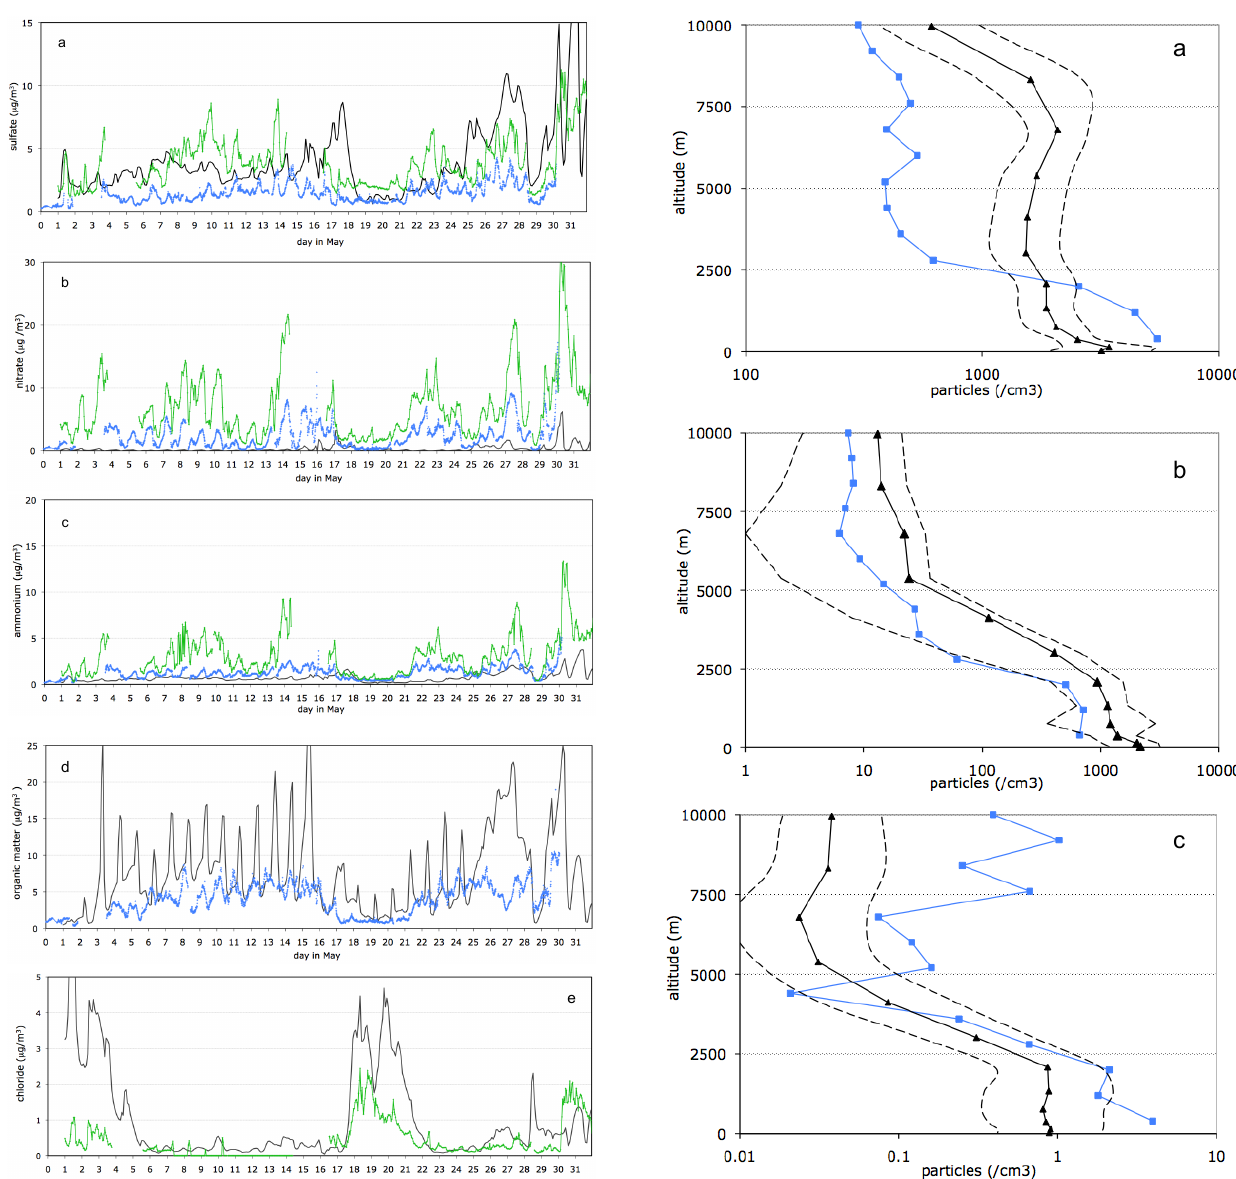
Figure 5. Observed (blue, green) and simulated (black) concentrations ( µ g/m 3 ) of a) sulfate, b) nitrate, c) ammonium, d) organics and e) chloride. Observations are from IMPACT, and simulation results pertain to the Cabauw grid point. Measurements in blue are from ICG-2 Jülich (Germany) and reflect particle sizes < 0.56 µ m diameter. Measurements in green are from ECN (The Netherlands) and reflect total aerosol mass.